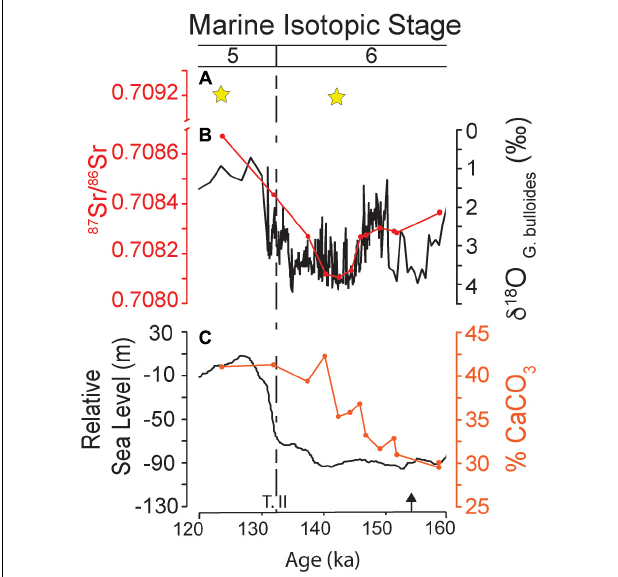
FIGURE 2 | (A) 87 Sr/ 86 Sr measured on pure biogenic foraminifera calcite (yellow stars, this study – PRGL 1-4), (B) δ 18 O G . bulloides (black line, Sierro et al., 2009) and 87 Sr/ 86 Sr measured on bulk carbonate (red line, this study – PRGL 1-4), (C) Red Sea sea level record (coreKL09, black curve, Grant et al., 2014) and %CaCO 3 measured on bulk carbonate (orange line, this study – PRGL 1-4). The black arrow indicates evidence of extensive melting of the Alpine ice-cap and local glaciers (Toucanne et al., 2009; Bickel et al.,